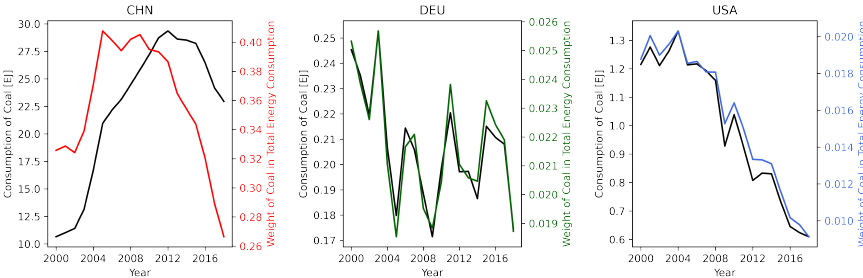
Figure 17. The evolution of coal consumption and its share in the total energy mix.